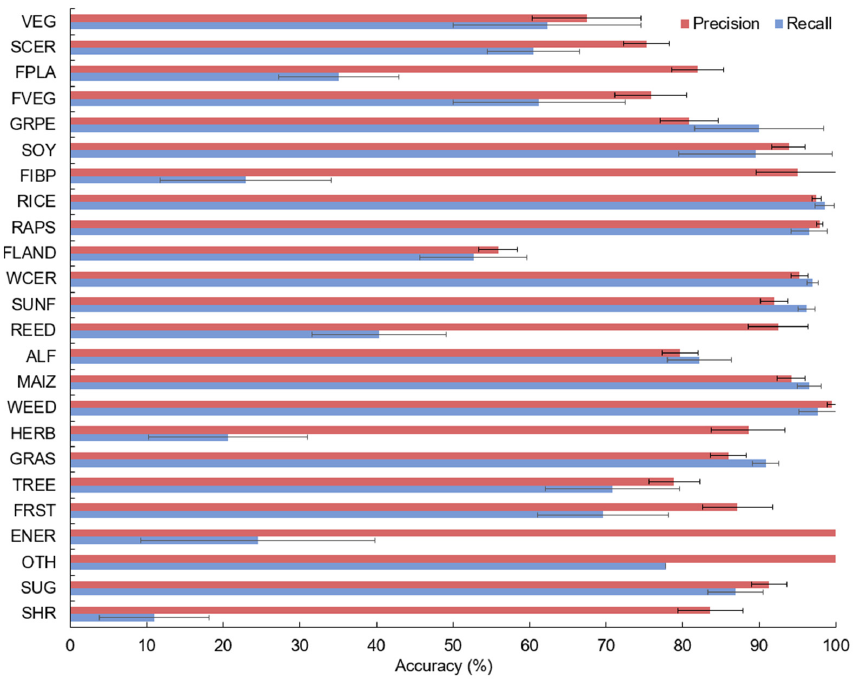
Figure 5. Precision and recall accuracies for the vegetation classes. Error bars represent the standard deviation calculated from the accuracies of the same class within the individual zones.